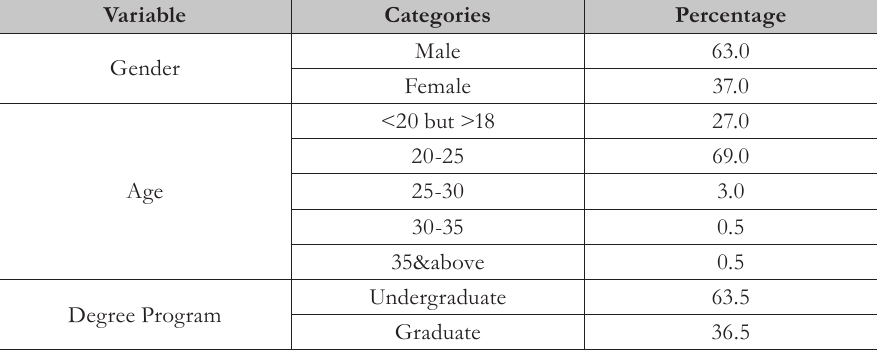
Tab. 1 – Demographic Information. Source: